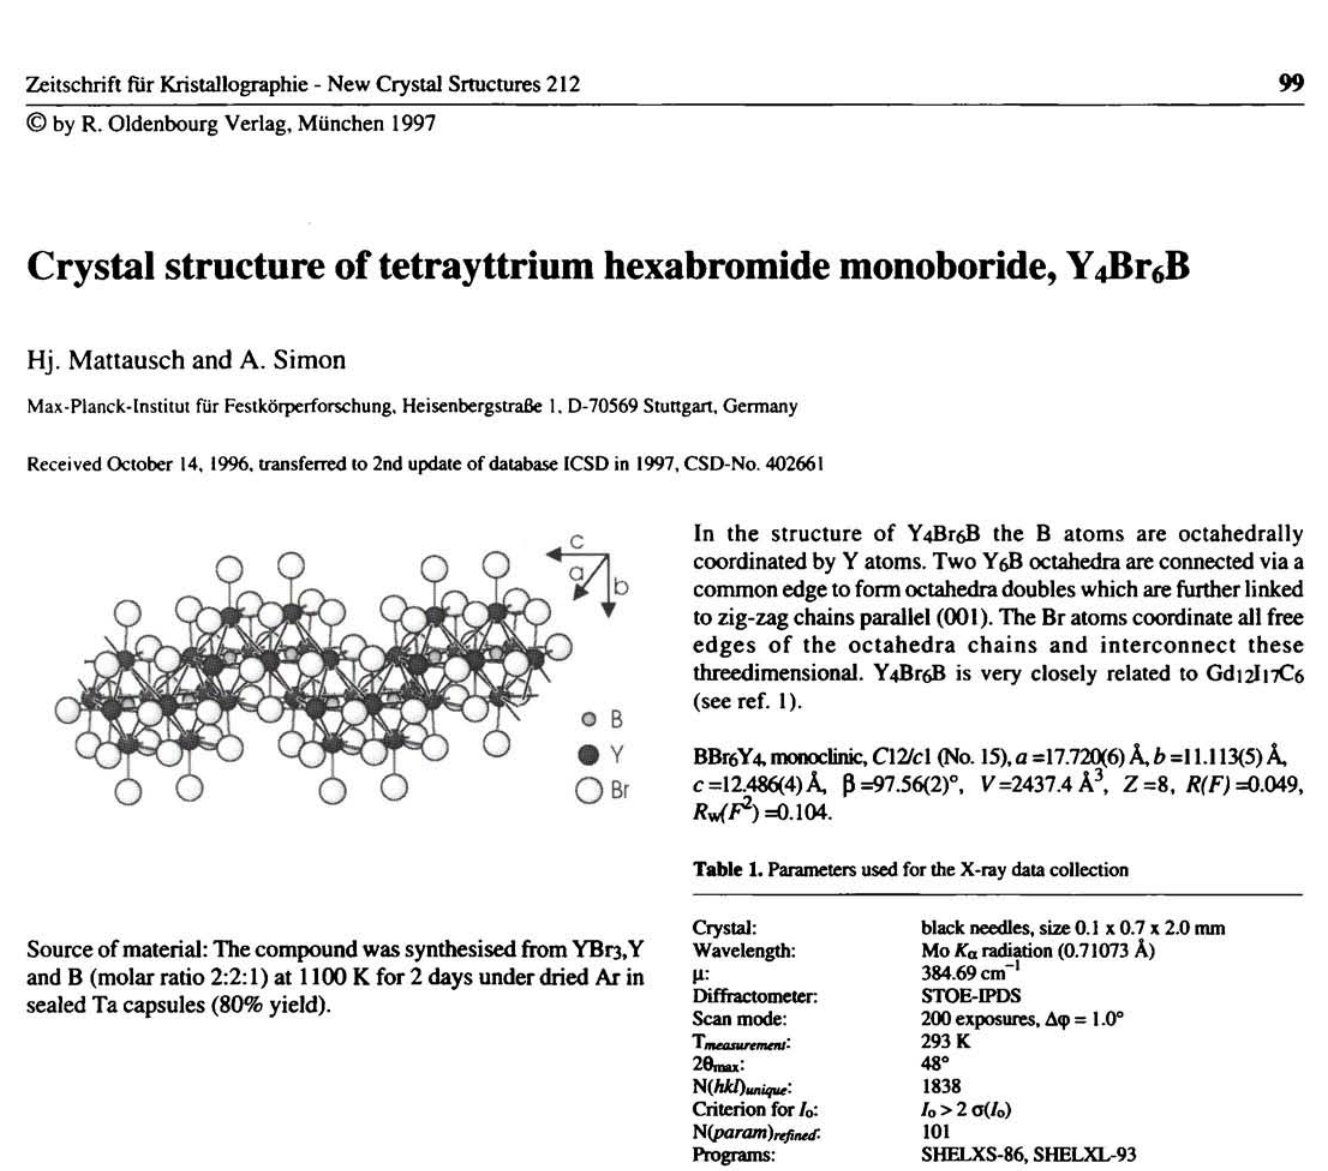
Table 2. Final atomic coordinates and displacement parameters (in À 2